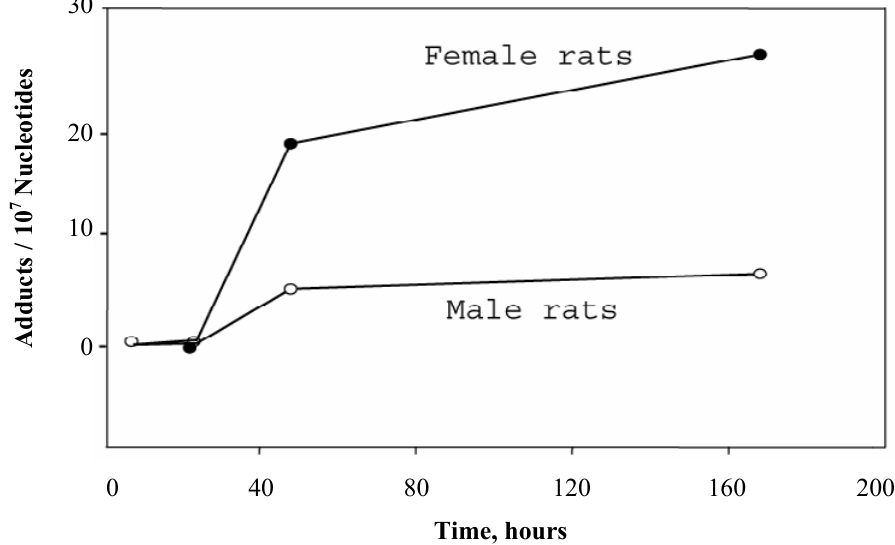
Figure 2. Time course of the formation and removal of the DHP-derived DNA adducts in blood DNA samples of rats treated with a single dose of riddelliine (10 mg/kg). Blood samples were collected from 3 rats per group and combined within the group. Data from liver DNA samples were the mean ± SD (n =